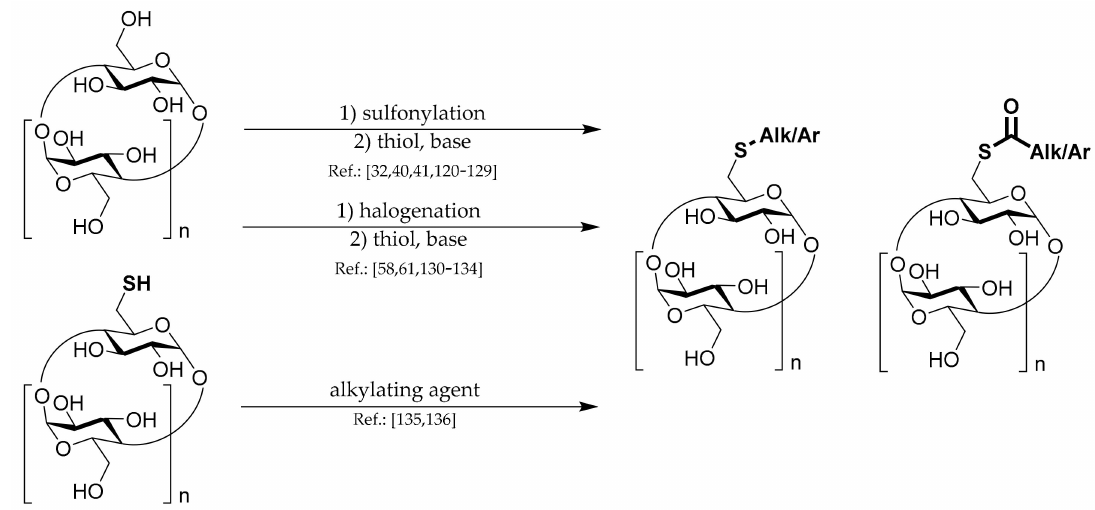
Scheme 5. General methods for preparation of 6 A - S -aryls/alkyls/acyls of